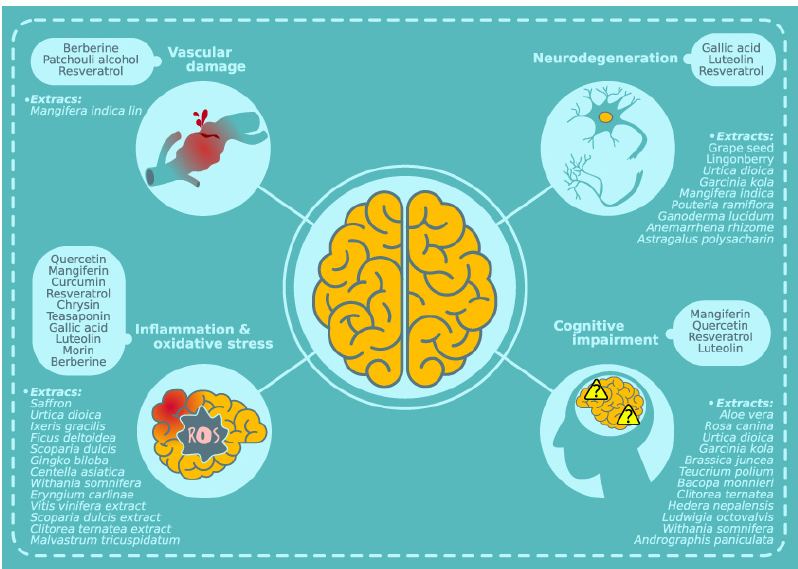
Figure 1. Central activities of natural compounds and extracts.